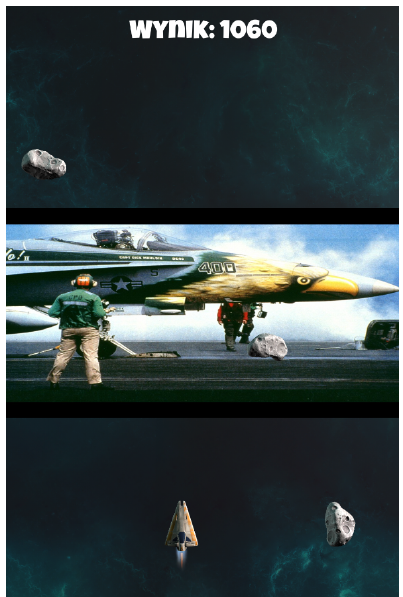
Figure 4. An example of the “Affective SpaceShooter 2” gameplay, asteroids falling, and an affective picture in the background